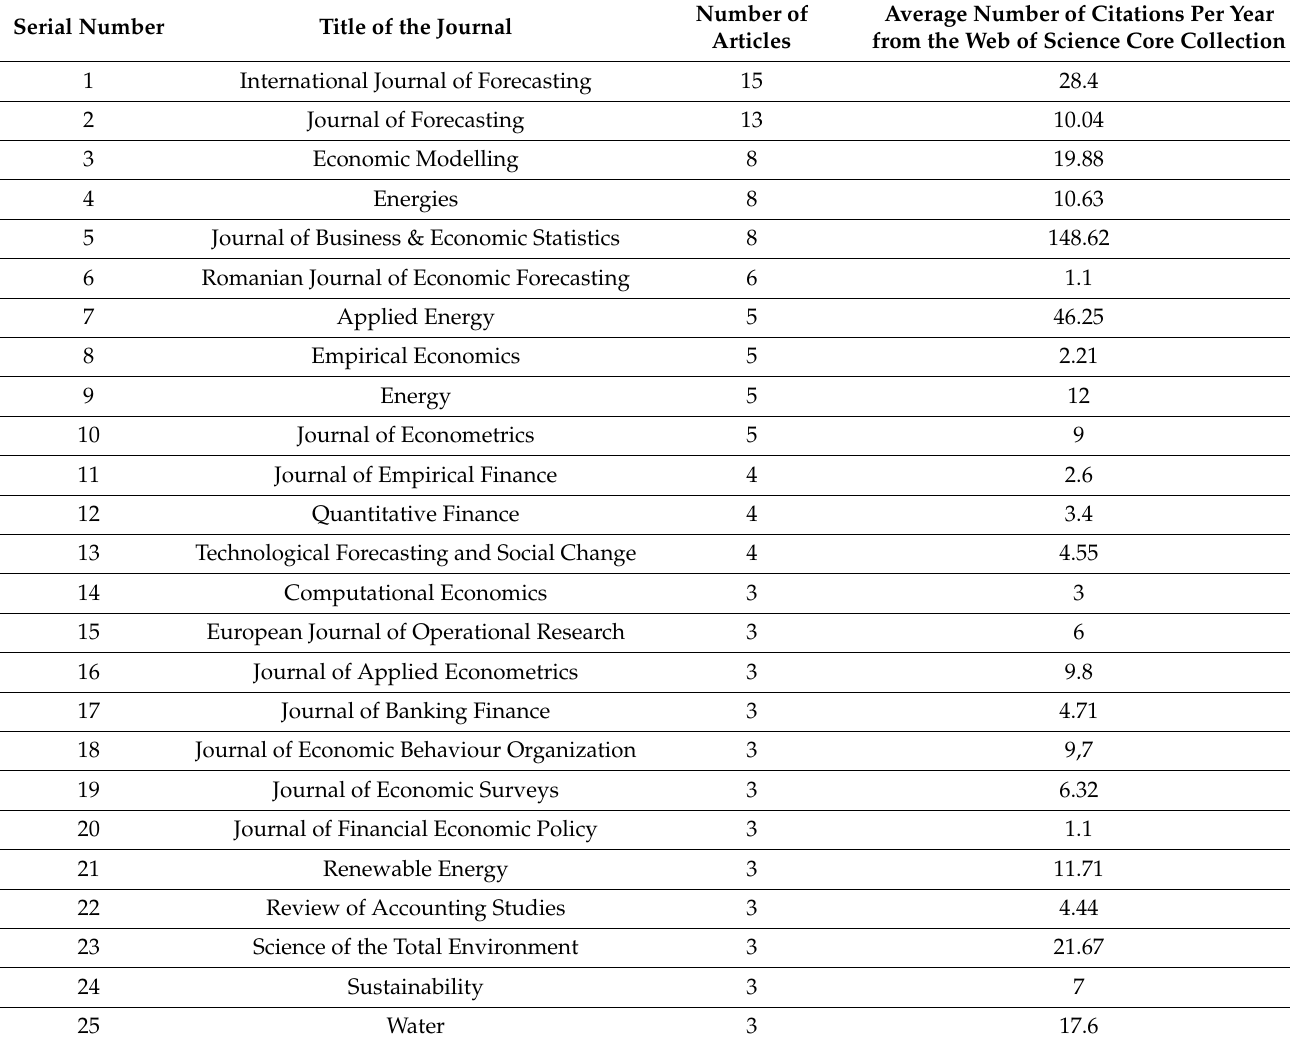
Table 4. The first 25 source titles (by record